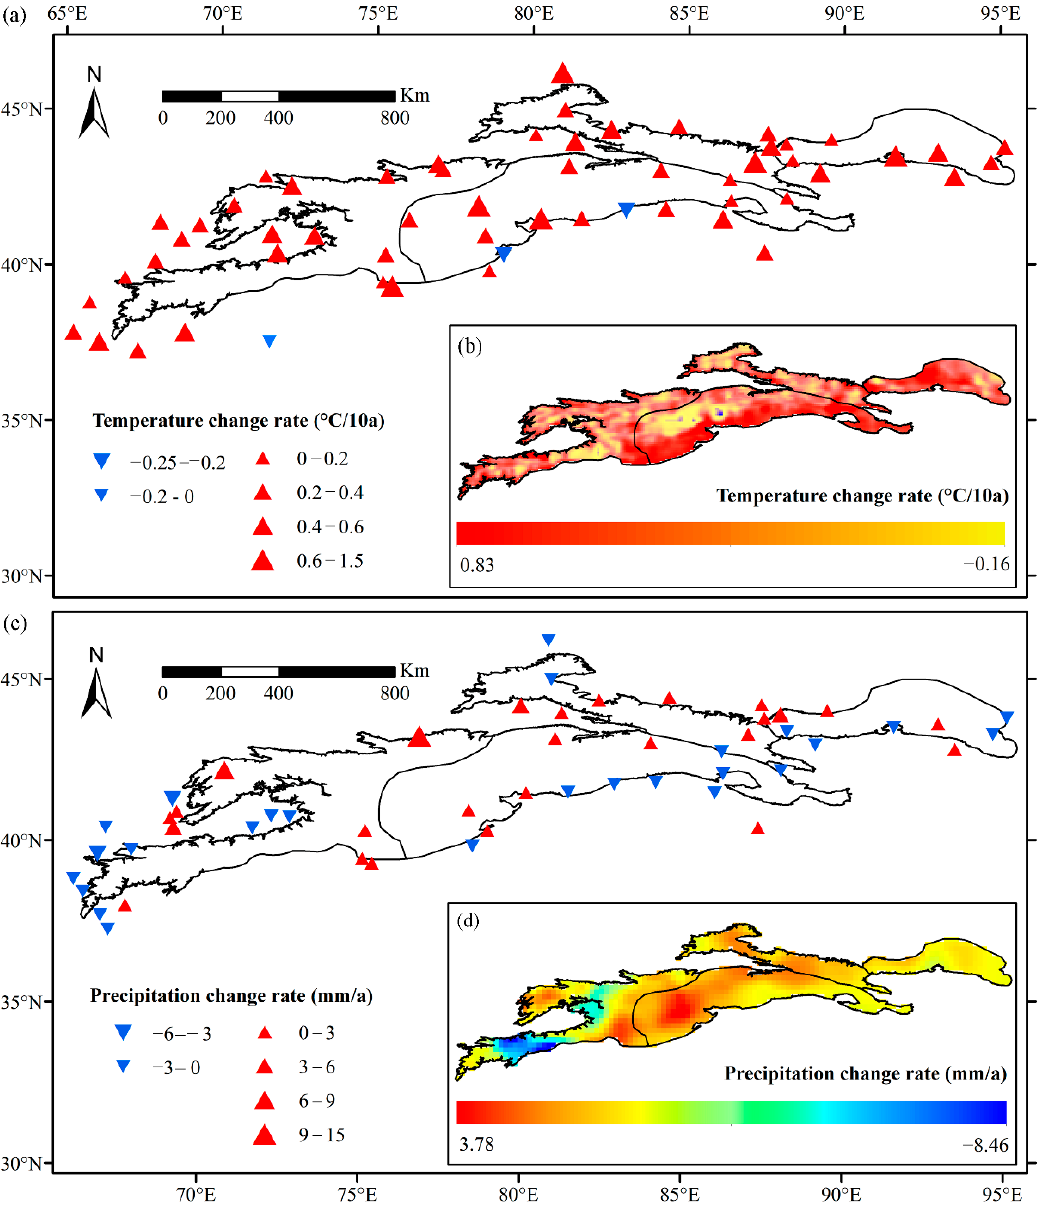
Figure 10. Variations in annual temperature and precipitation in the Tien Shan from 1990 to 2015. ( a ) Variations in temperature from the meteorological stations and ( b ) ERA5 data set; ( c ) variations in precipitation from the meteorological stations and ( d ) GPCC data set.